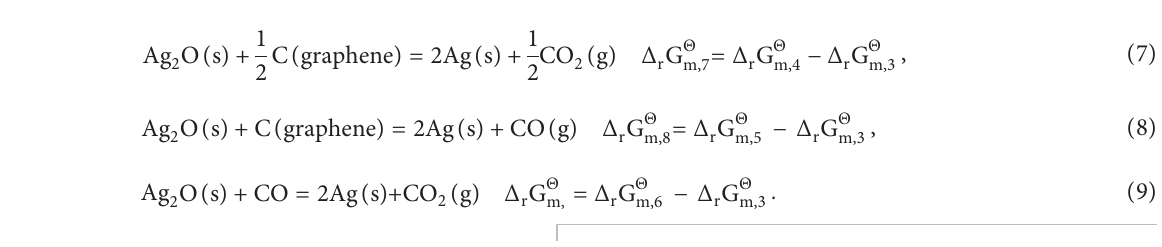
Figure 1: Schematic illustration for the formation process of G@Ag/ASO composite. The AgSb the surface of graphene to form into G@Ag/ASO